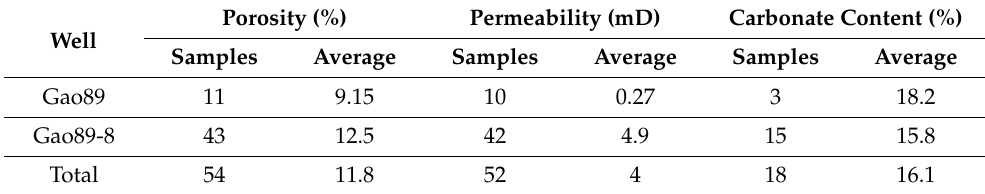
Table 1. Physical property data sheet of coring wells.